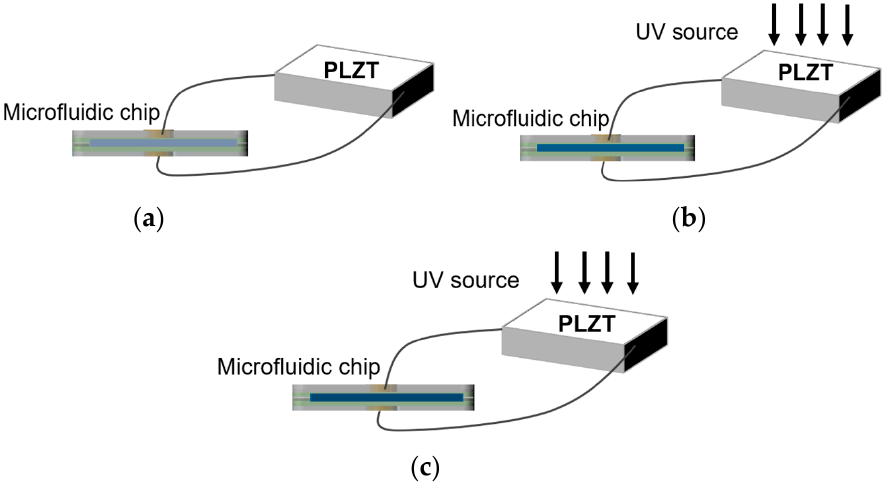
Figure 2. Schematic diagram showing ERF flow inside a microfluidic chip under different light intensities. ( a ) Light intensity of 0 mW/cm 2 ; ( b ) light intensity of 50 mW/cm 2 ; and ( c ) light intensity of 150 mW/cm 2 .